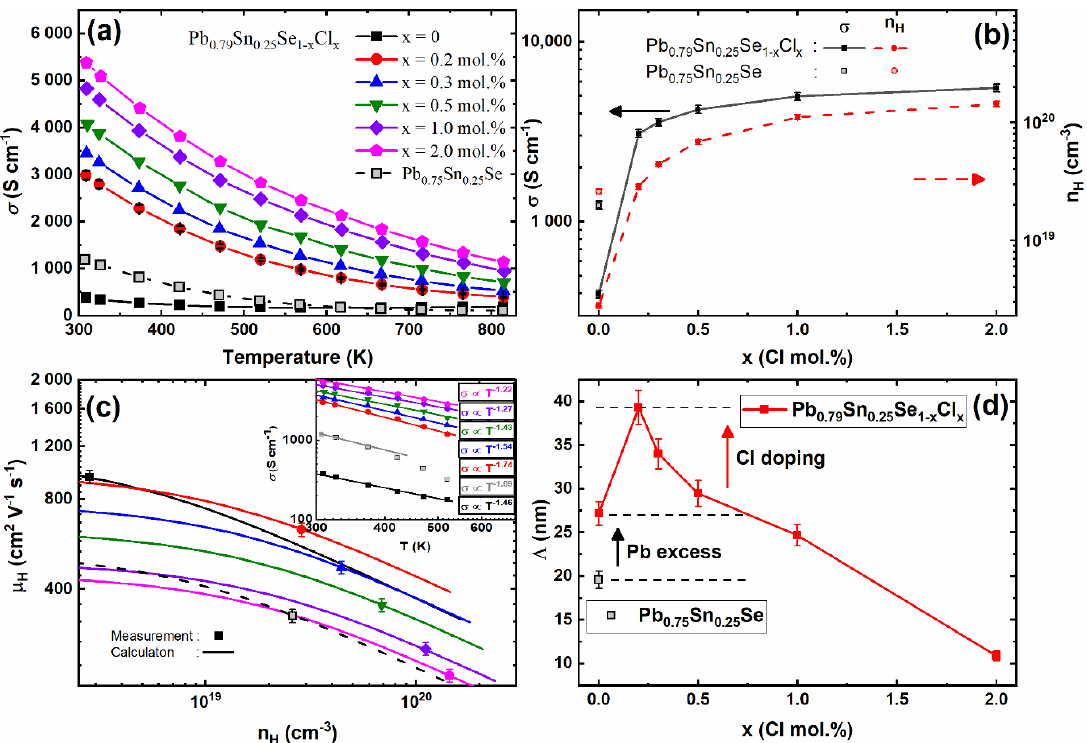
Figure 3. ( a ) Temperature-dependent electrical conductivity σ (T) ; ( b ) the electrical conductivity (left axis) and Hall carrier concentration (right axis) as a function of the Cl-doping concentration; ( c ) the Hall mobility with the Hall carrier concentration (inset shows σ (T) with the linear fitted line by the relation of the σ ∝ T -n ); ( d ) the mean free path Λ of the carrier as a function of the Cl-doping concentration of the Pb 0.79 Sn 0.25 Se 1 − x Cl x (x = 0, 0.2, 0.3, 0.5, 1.0, 2.0 mol.%) and Pb 0.75 Sn 0.25 Se compounds at 300 K.